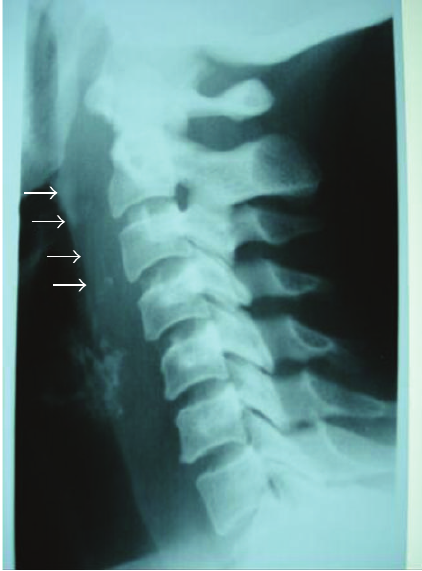
FIGURE 2: Prevertebral thickening in the radiography of cervical